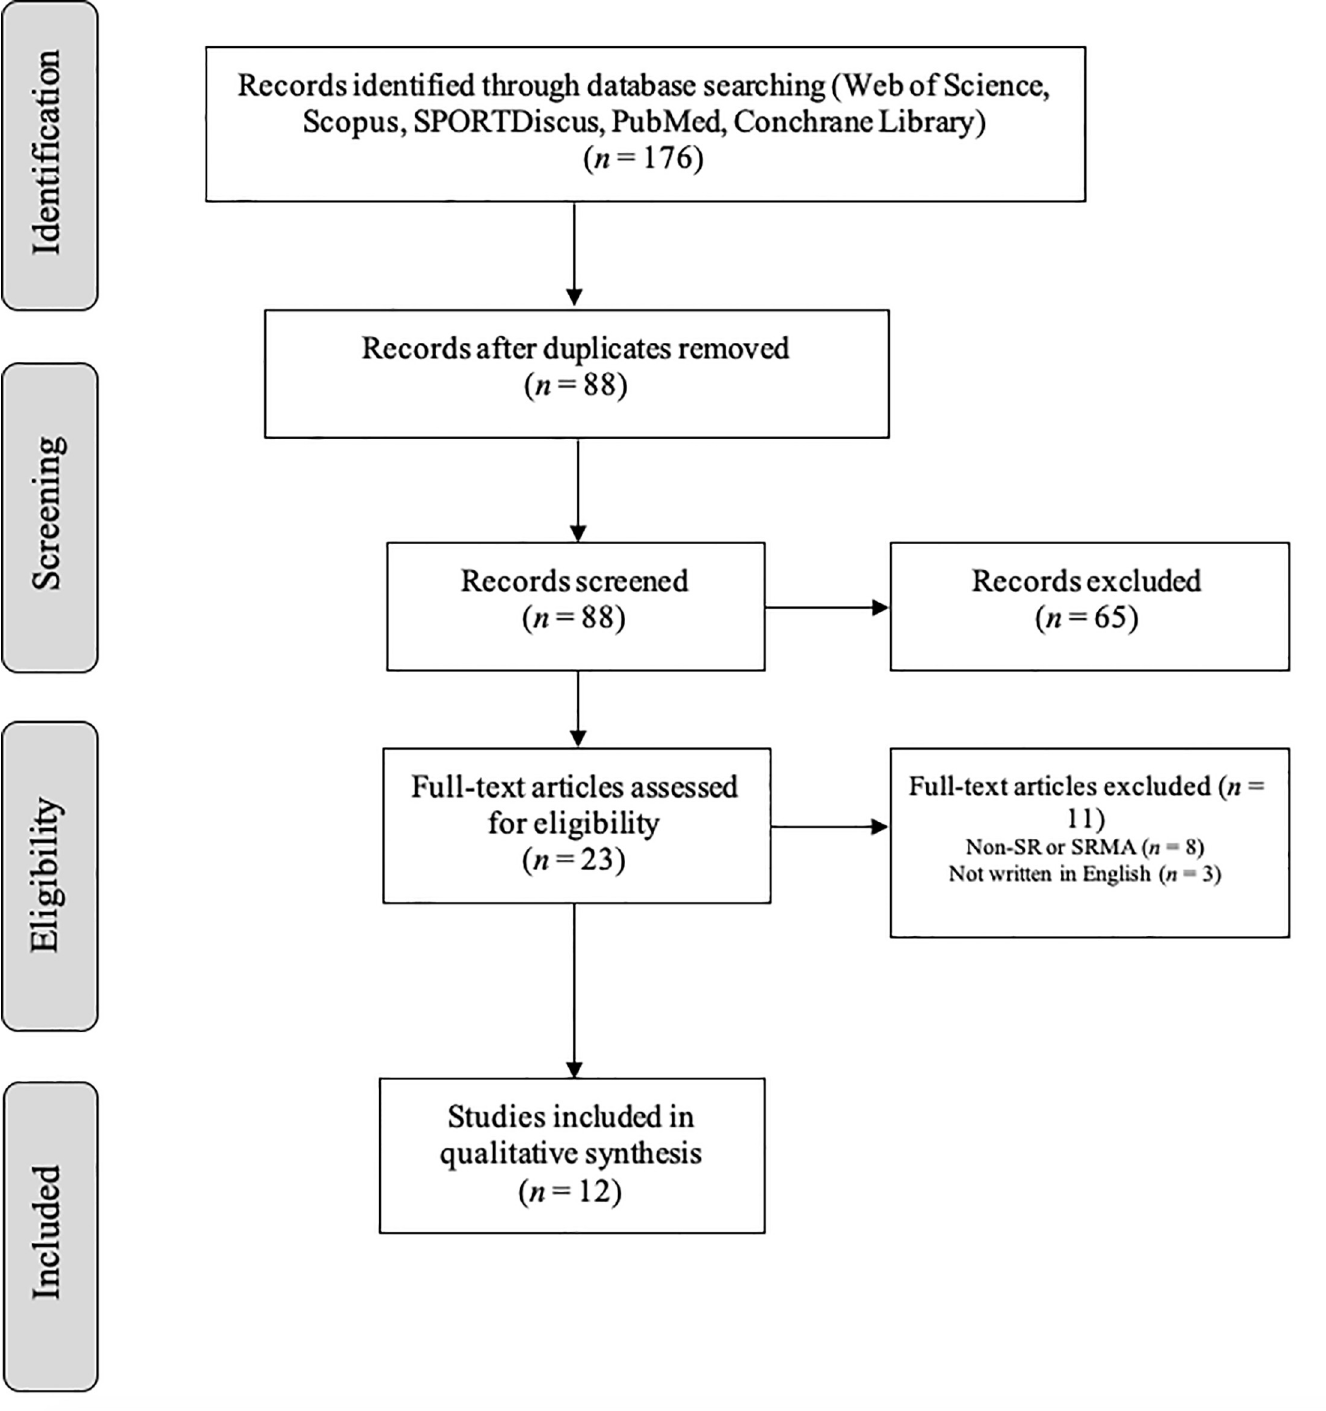
Fig 1. PRISMA flow diagram highlighting the selection process for the studies included in the umbrella-review.